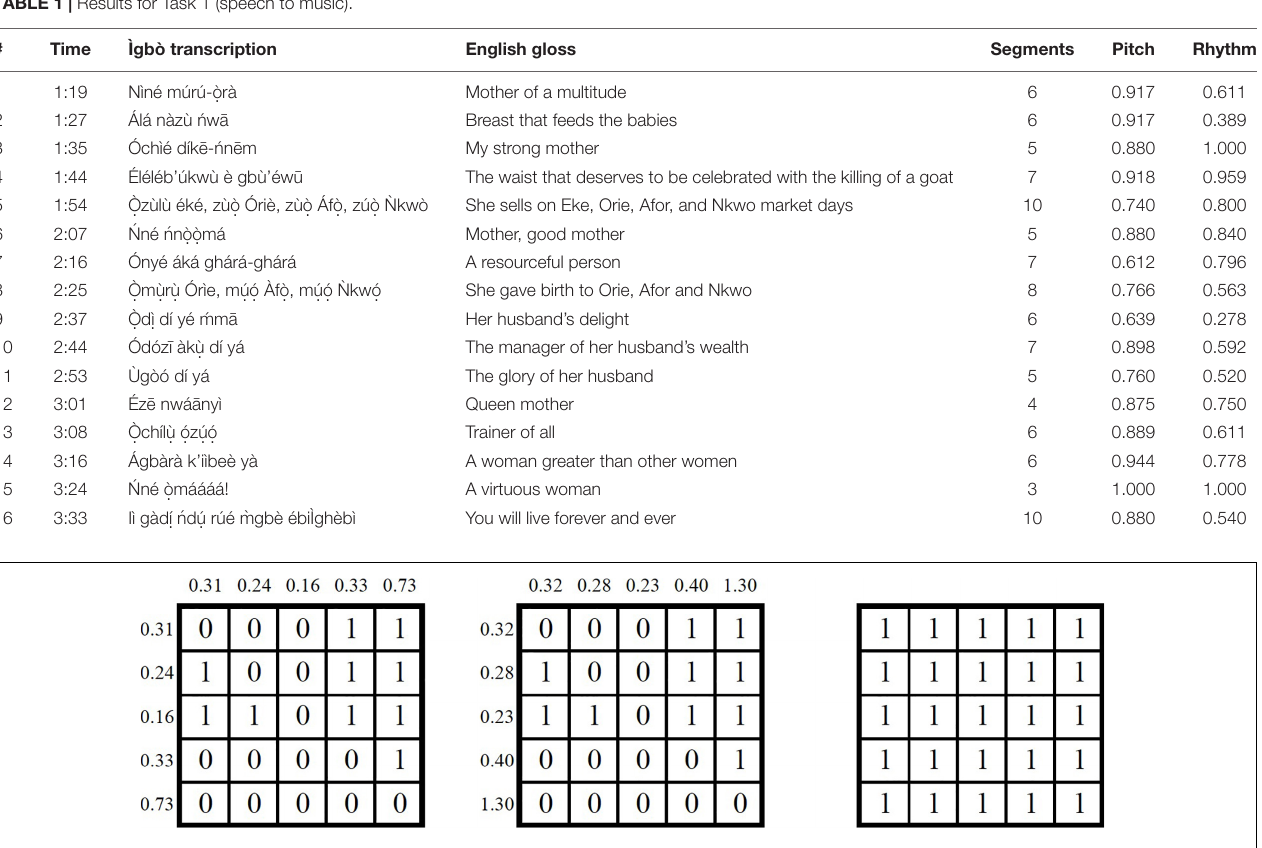
first two matrices, yielding all “1” values because all entries in the first two matrices match each other, yielding 100%